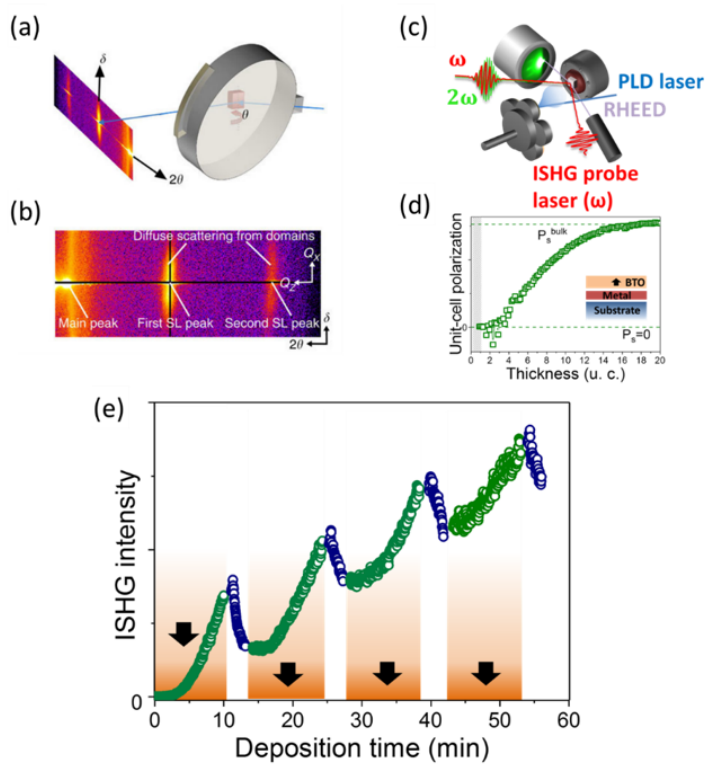
Figure 17. Characterization of the polar state during the growth. ( a ) Schematic of the in situ X-ray diffraction experiment, ( b ) Example of diffraction results for a BTO/STO superlattice. ( a , b ) Reprinted from [21]. ( c ) Schematic of the in situ SHG experimental setup. ( d ) In situ SHG measurement showing the emergence of polarization during the growth of a BTO thin film. ( e ) In situ SHG during the deposition of a BFO/SRO multilayer with a parallel polarization configuration. ( c – e ) Reprinted with from